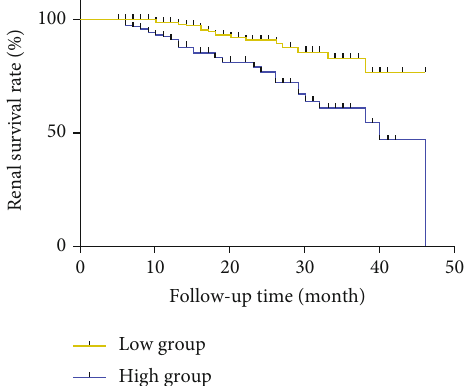
Figure 2: Kaplan-Meier renal survival curves for patients with IgA nephropathy (IgAN) according to serum chloride levels. Patients with IgAN were classi fi ed into two groups according to serum chloride levels: a low chloride group ( < 105.4mmol/L, red line) and a high chloride group ( ≥ 105.4 mmol/L, blue line). Log-rank rest revealed that the cumulative renal survival rates in the high chloride group were signi fi cantly worse than those in the low chloride group ( p < 0 : 001 ).